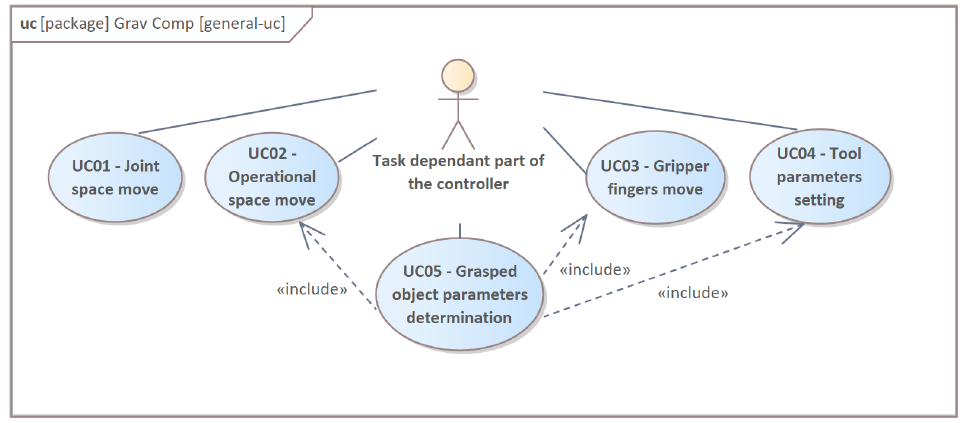
Figure 1. System general use